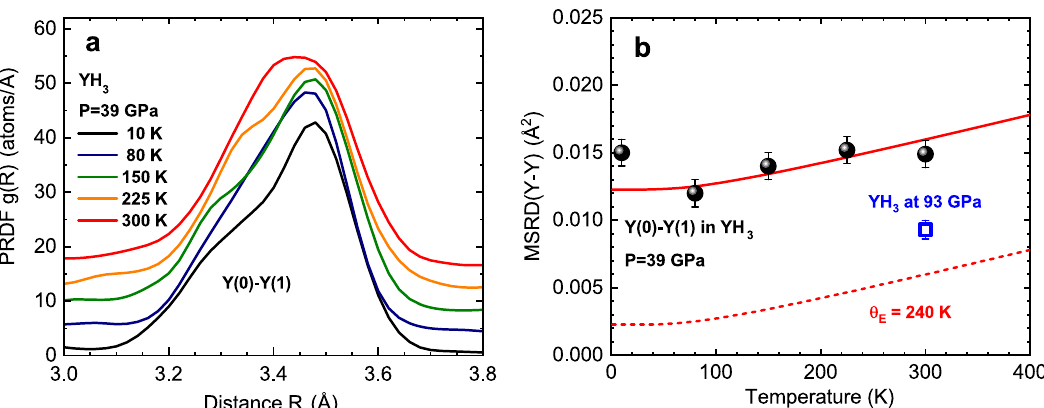
Fig. 6 Temperature-dependent studies. a The pair radial distribution functions (PRDF) for YH 3 in fcc phase at 39 GPa obtained from RMC simulations, and b the temperature dependence of the MSRD for the Y – Y bond in the fi rst Y(0) – Y(1) coordination shell around Y(0). The dashed curve shows the Einstein harmonic model for the Y – Y atom pair with Einstein ’ s characteristic temperature Θ E = 240 K. Meanwhile, the solid curve represents the Einstein model, shifted due to the static disorder contribution. The MSRD (blue open square) for the fi rst yttrium shell in fcc YH 3 phase at 93 GPa and 300 K is shown for comparison.